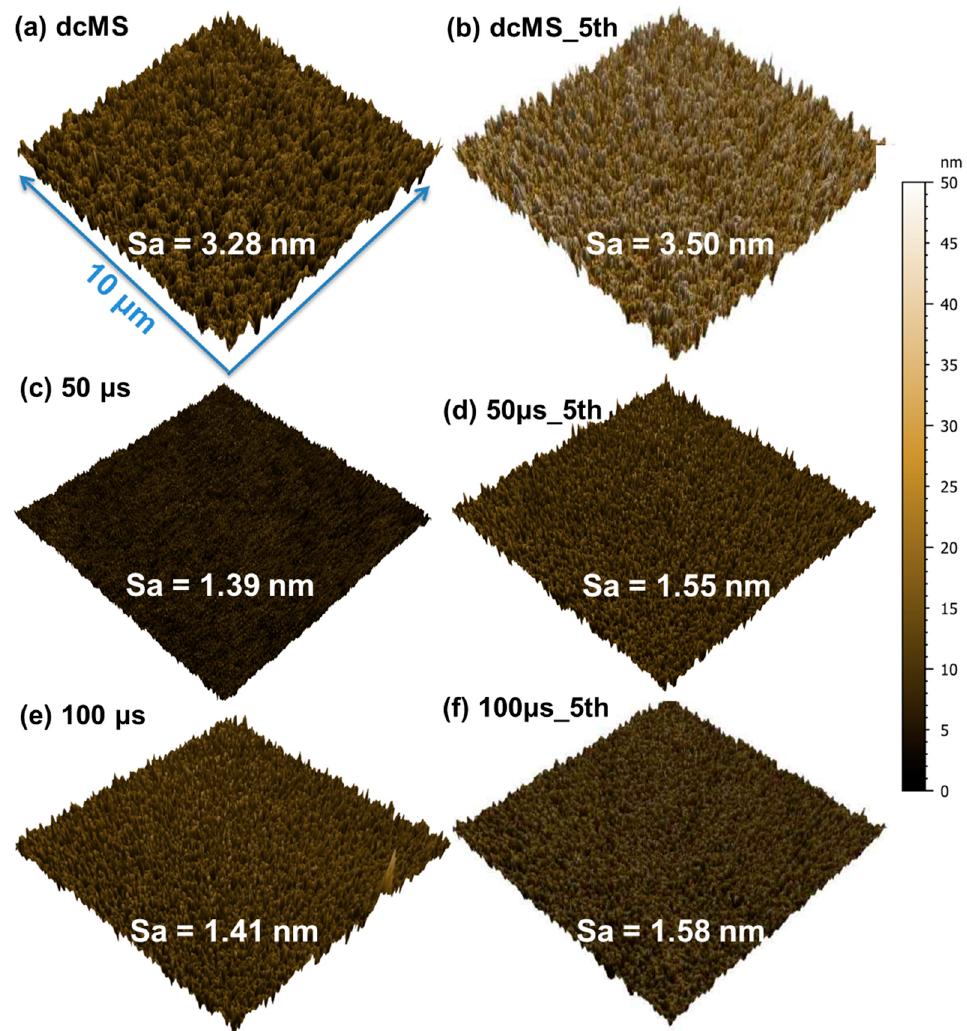
Figure 7. AFM morphologies and roughness of W films prepared by dcMS and HiPIMS after cycle thermal resistance measurements.